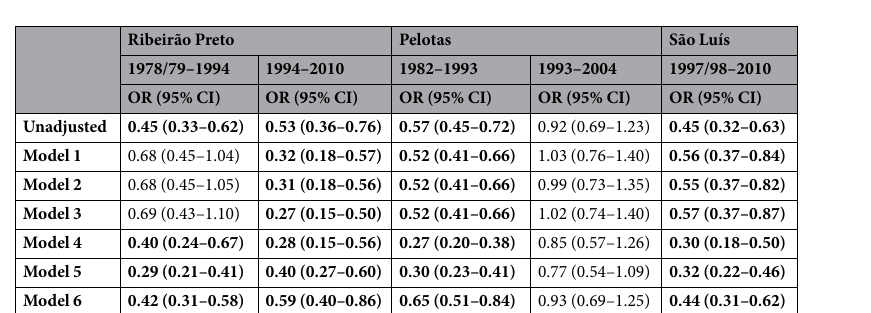
Table 1. Hierarchical analysis of the association between year and infant mortality in Ribeirão Preto (1978/79, 1994 and 2010), Pelotas (1982, 1993 and 2004) ad São Luís (1997/98 and 2010). OR: Odds ratio; CI: Confidence Interval. Values highlighted are those with significant statistical results. Model 1 : Adjusted for sociodemographic characteristics; Model 2 : Adjusted for sociodemographic characteristics + maternal and gestational characteristics; Model 3 : Adjusted for sociodemographic + maternal and gestational + health care characteristics; Model 4 : Adjusted for sociodemographic + maternal and gestational + health care and newborn characteristics; Model 5 : Adjusted for gestational age; Model 6 : Adjusted for intrauterine growth